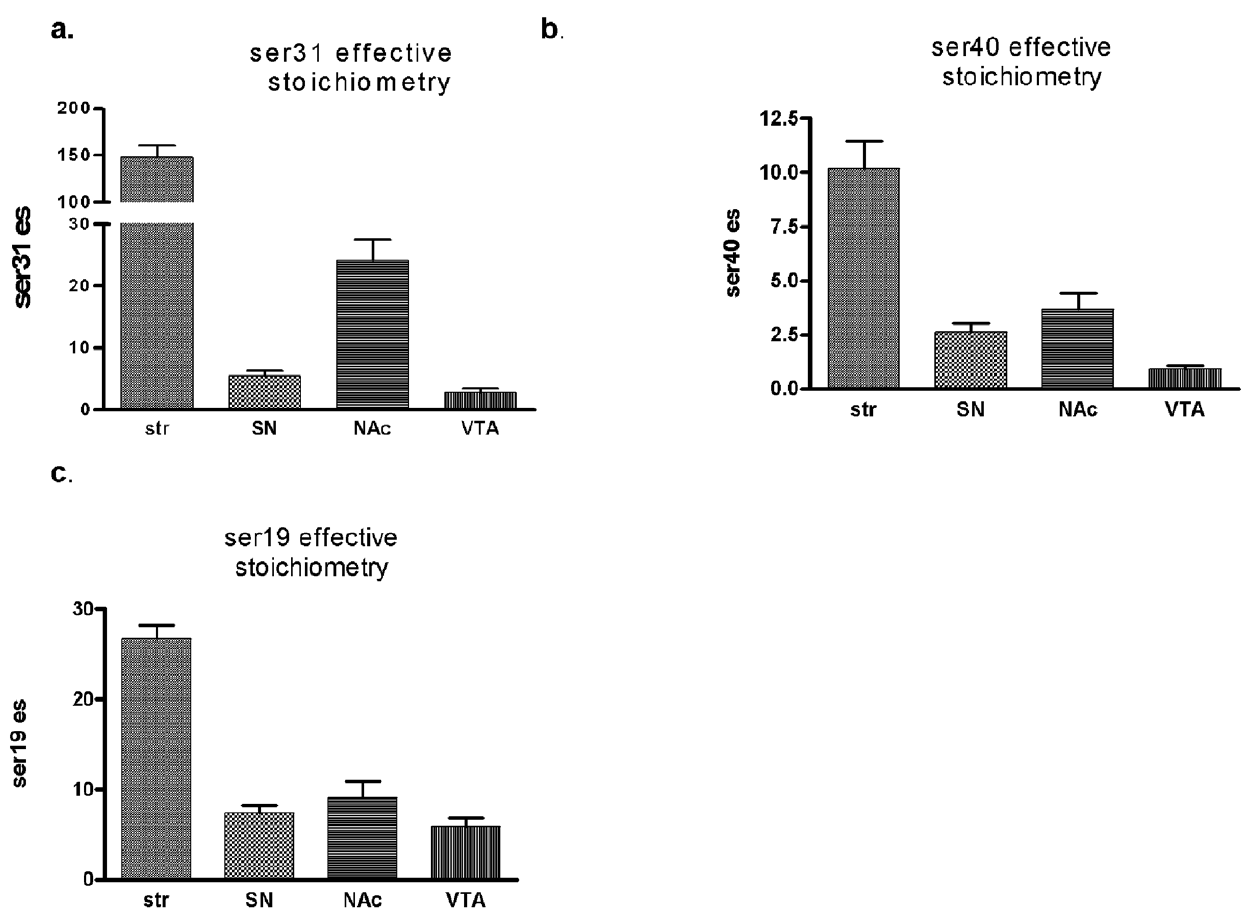
Figure 2. Tyrosine hydroxylase effective stoichiometry in nigrostriatal and mesoaccumbens pathways. Values are obtained by multiplying total inherent TH protein content by phosphorylation stoichiometry in each sample. a. Ser31 es . Stoichiometry determined by anti- phospho ser31 TH against calibrated standards for ser31 and divided by total TH protein. b. Ser40 es c. ser19 es Values were calculated based upon each subject’s ps value and multiplied by the mean total TH. Region-to-region difference for ser31 es was similar to the difference in total DA (as shown in Fig. 1a ) recovered from the longitudinally-characterized inherent locomotor activity patterns for the test subjects.